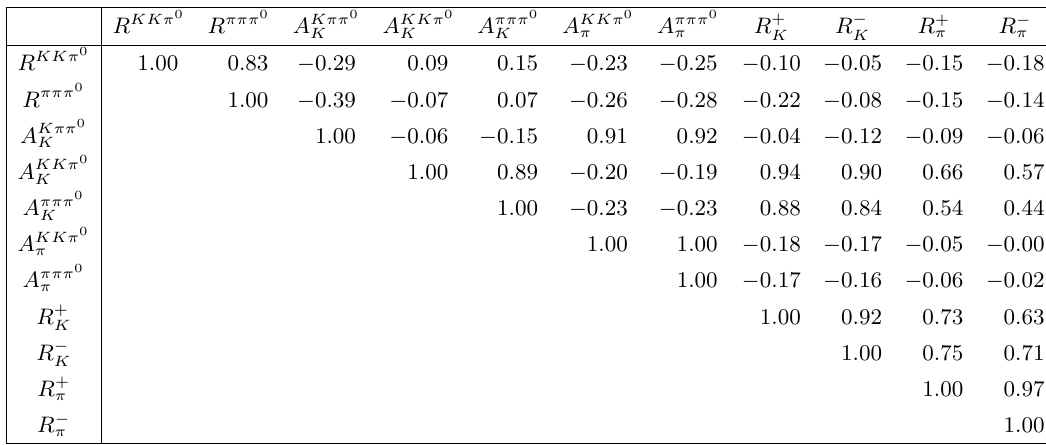
Table 4 . Correlation matrix for systematic